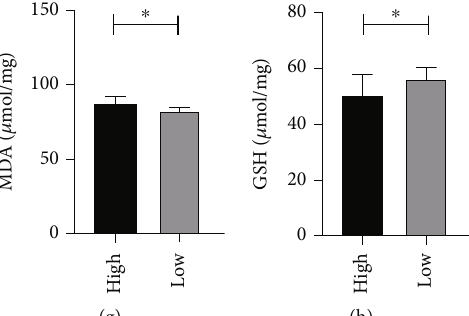
Figure 1: (a) Heat map to identify di ff erentially expressed lncRNAs between cisplatin-resistant and cisplatin-sensitive patients. (b) LINC02389 expression in non-small-cell lung cancer patients and adjacent normal tissues. (c) LINC02389 expression in recurrent and nonrecurrent non-small-cell lung cancer patients. (d) Survival analysis for LINC02389 high and low expressed non-small-cell lung cancer patients. (e, f) MDA and GSH expressions in recurrent and nonrecurrent non-small-cell lung cancer patients. (g, h) MDA and GSH expressions in LINC02389 high and low expressed non-small-cell lung cancer 5 : 38 (Figure 3(a)). We found that LINC02389 was overex-